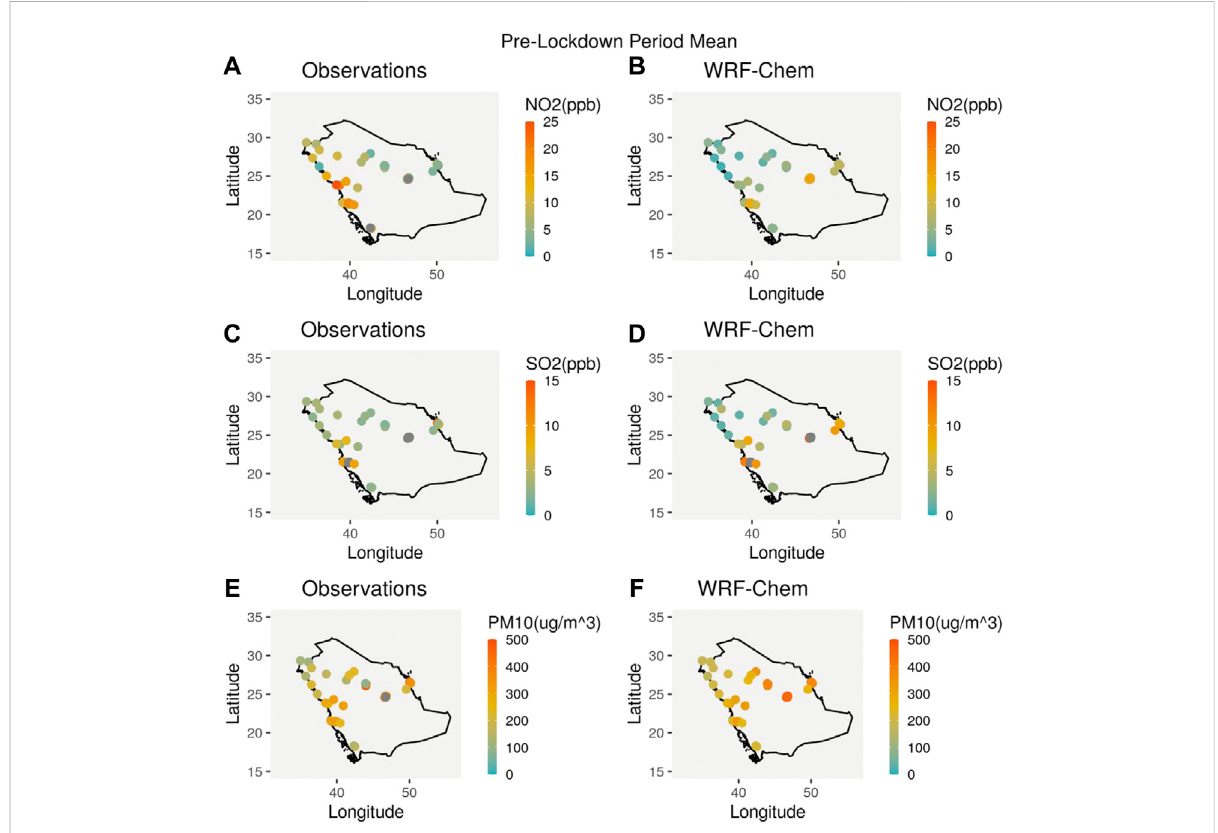
FIGURE 1 Comparison of pollutants NO 2 , SO 2 and PM 10 between ground-based observations (A, C, E) over different regions in KSA and WRF-chem simulations (B, D, F) during